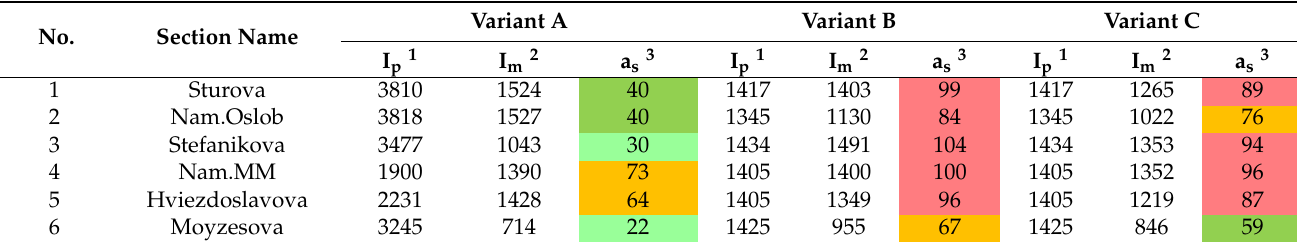
Table 11. Results of the capacity load of local roads in the internal traffic circuit (source elaborated by authors).